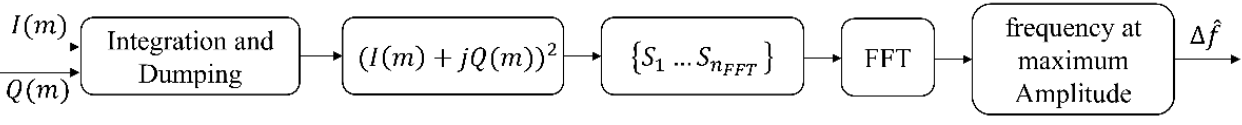
Figure 3. FFT discriminator block diagram.